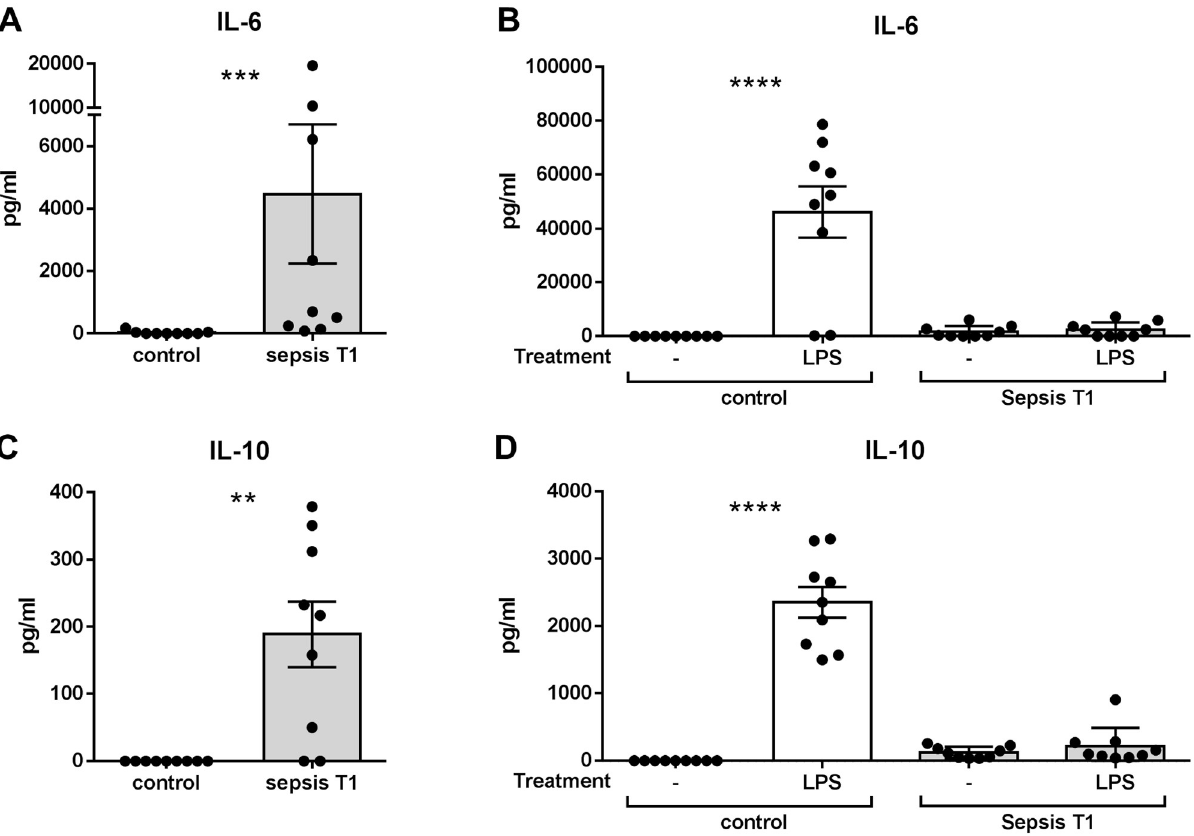
Fig 2. Cytokine levels in plasma and supernatants from ex-vivo stimulated samples. Plasma levels of pro- and anti-inflammatory cytokines from patients with sepsis at the time of sepsis diagnosis (T1) were compared with healthy control patients. IL-6 levels in (A) plasma (p < 0.001, Mann- Whitney U test, control patients n = 9, patients with sepsis n = 9, mean ± SEM) and (B) in supernatants after ex-vivo stimulation with LPS (p < 0.0001, Mann-Whitney U test, control patients n = 9, patients with sepsis n = 9, mean ± SEM). IL-10 levels in (C) plasma (p < 0.01, Mann-Whitney U test, control patients n = 9, patients with sepsis n = 9, mean ± SEM) and (D) in supernatants after ex-vivo stimulation with LPS (p < 0.0001, Mann-Whitney U test, control patients n = 9, patients with sepsis n = 9, mean ± SEM).